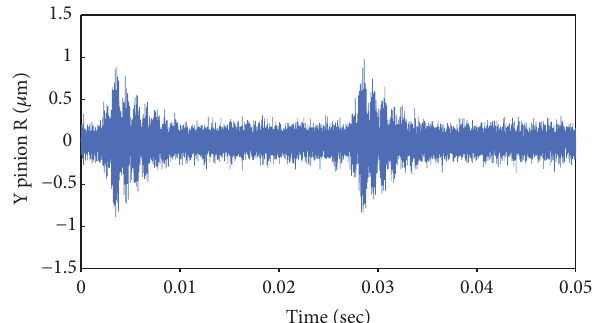
Figure 30: Residual signal obtained for the fourth scenario (Case (7) with consecutive cracked teeth).